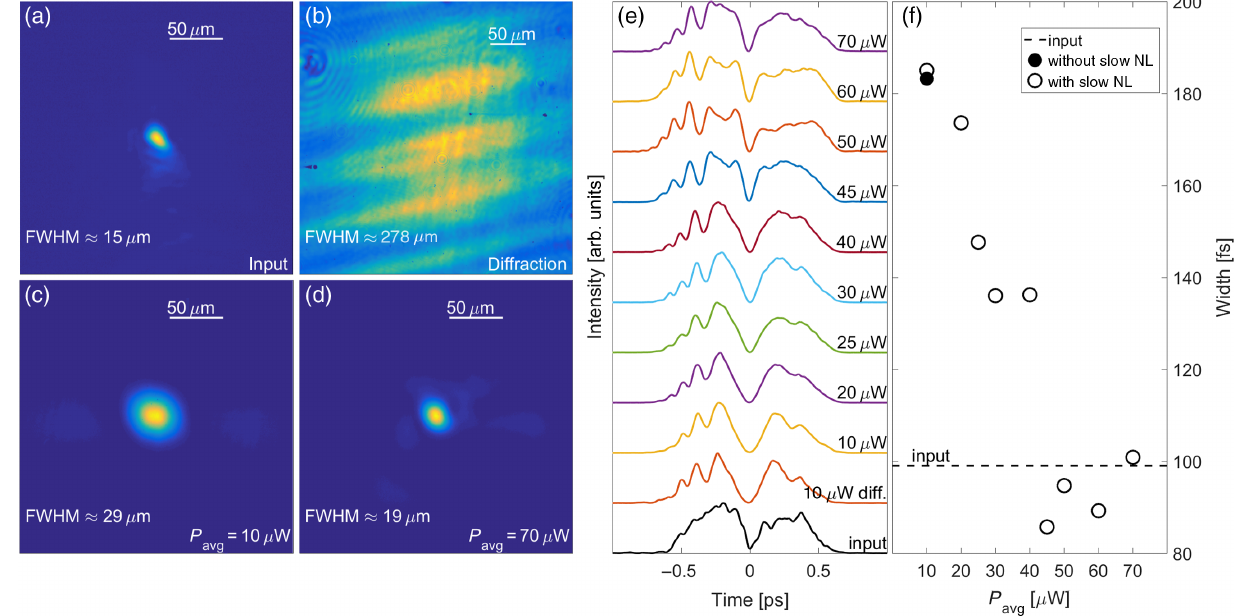
FIG. 2. Three-dimensional spatiotemporal pulse-train soliton in a long crystal ( L ¼ 15 mm). (a) Spatial intensity distribution at the input plane of the crystal (FWHM ≈ 15 μ m). (b) The intensity distribution at the output plane of the crystal under approximately linear propagation condition (the screening self-focusing is turned off by applying zero external voltage and the Kerr nonlinearity is small because the intensity of the beam is low — 10 μ W averaged power of the incoming beam). The beam broadens to FWHM ≈ 278 μ m. Output plane intensity distributions when the screening self-focusing is turned on ( V ¼ 500 V) at (c) 10 μ W and (d) 70 μ W averaged powers, demonstrating the transverse spatial self-trapping (FWHM ≈ 29 μ m and FWHM ≈ 19 μ m, respectively). (e) Reconstructed ¼ 10 μ W (red), and spatially trapped beam with intensity pulse profiles of (bottom up) input pulse (black), diffracted beam with P avg P ¼ 10 , 20, 25, 30, 40, 45, 50, 60, and 70 μ W. (f) The duration of the dark notch as a function of average power demonstrating the avg temporal confinement. The horizontal dashed line corresponds to the duration at the input